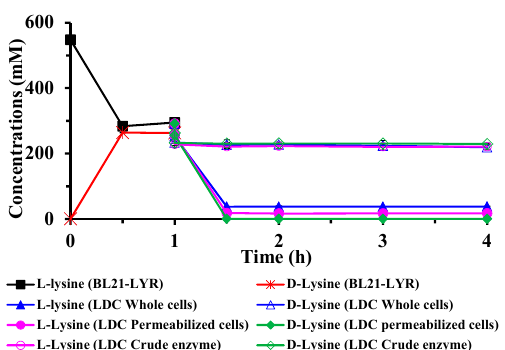
Figure 3. Comparison of the decarboxylation activities of resting whole cells, permeabilized cells, and cell extracts of E. coli AST3 expressing lysine decarboxylase. The whole ‐ cell BL21 ‐ LYR was first employed to racemizing L ‐ lysine to generate DL ‐ lysine. Subsequently, L ‐ lysine in the DL ‐ lysine mixture was degraded by the biocatalysts of E. coli ATS3.